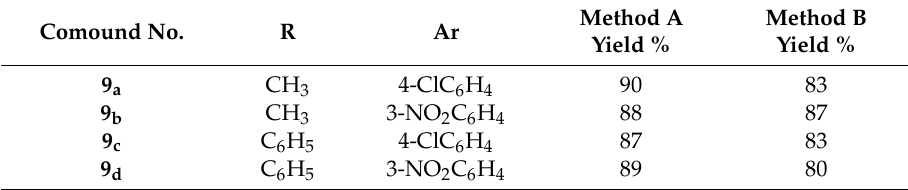
Table 3. Yield comparison of triethylamine and ammonia methods for synthesis of deprotected galactosides ( 9 a–d ).